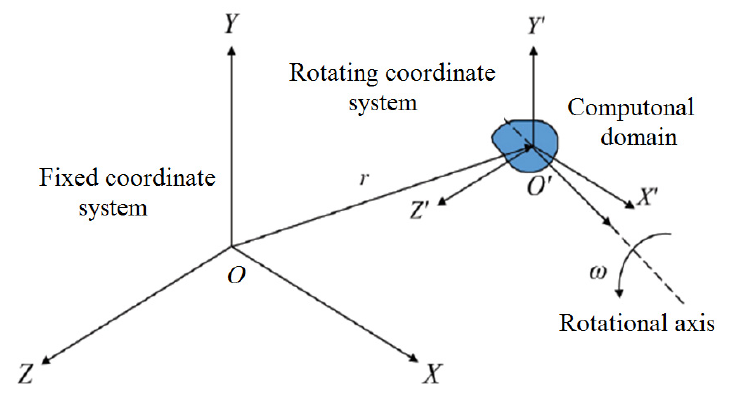
Figure 4. Coordinate transformation principle of MRF.